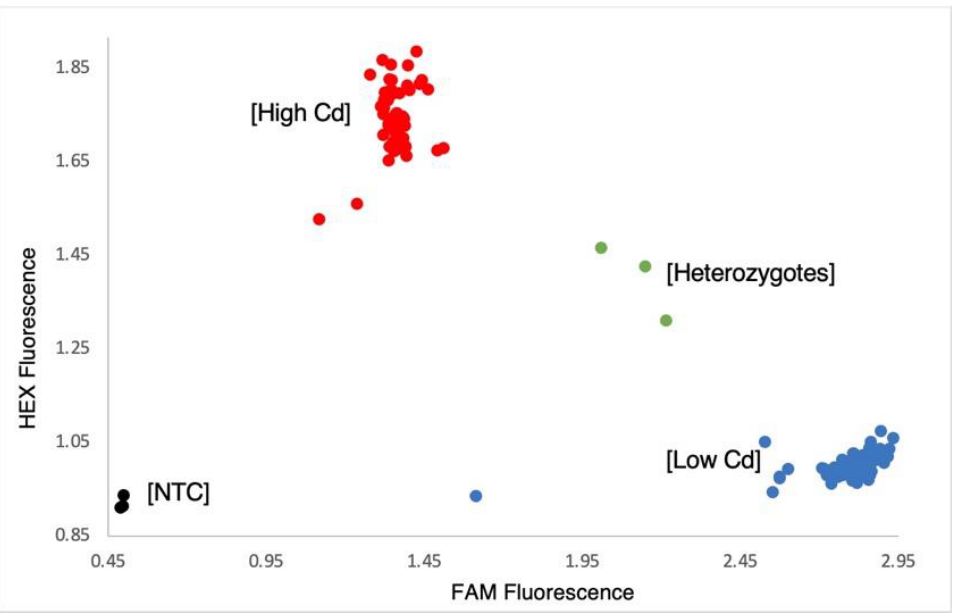
Figure 5. KASP assay screening for Cda1 using HEX and FAM fluorescent fluorophores. Shown in red are the soybean lines with high seed Cd concentration accumulation presented by HEX fluorescence, and in blue are the low seed Cd concentration cultivars presented by FAM fluorescence, while the heterozygotes are shown in green. The no template control (NTC) is shown in black. A total of 165 lines, including parents of the X5154 and X4050 populations investigated by the KASP marker, are presented in Supplementary File S3.